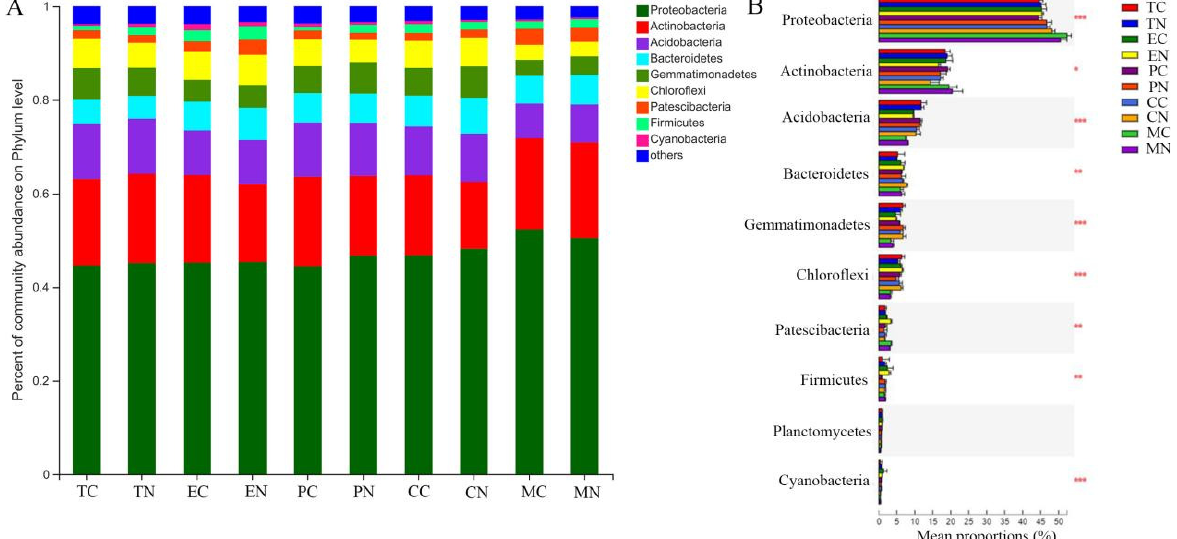
Figure 4. Analysis of compositions of bacterial communities from CK and NCD-2 treatments in different crops. ( A ) Percentage of community abundance at phylum level for each crop; ( B ) Significant analysis of community abundance at the phylum level. *, ** and *** means significantly at p < 0.05, p < 0.01 and p < 0.001 level, respectively. NCD-2 represents treatment with B. subtilis NCD-2, CK represents treatment with blank control. TC, tomato-CK; TN, tomato-NCD-2; EC, eggplant-CK; EN, eggplant-NCD-2; PC, pepper-CK; PN, pepper-NCD-2; CC, cotton-CK; CN, cotton-NCD-2; MC, maize-CK; MN,